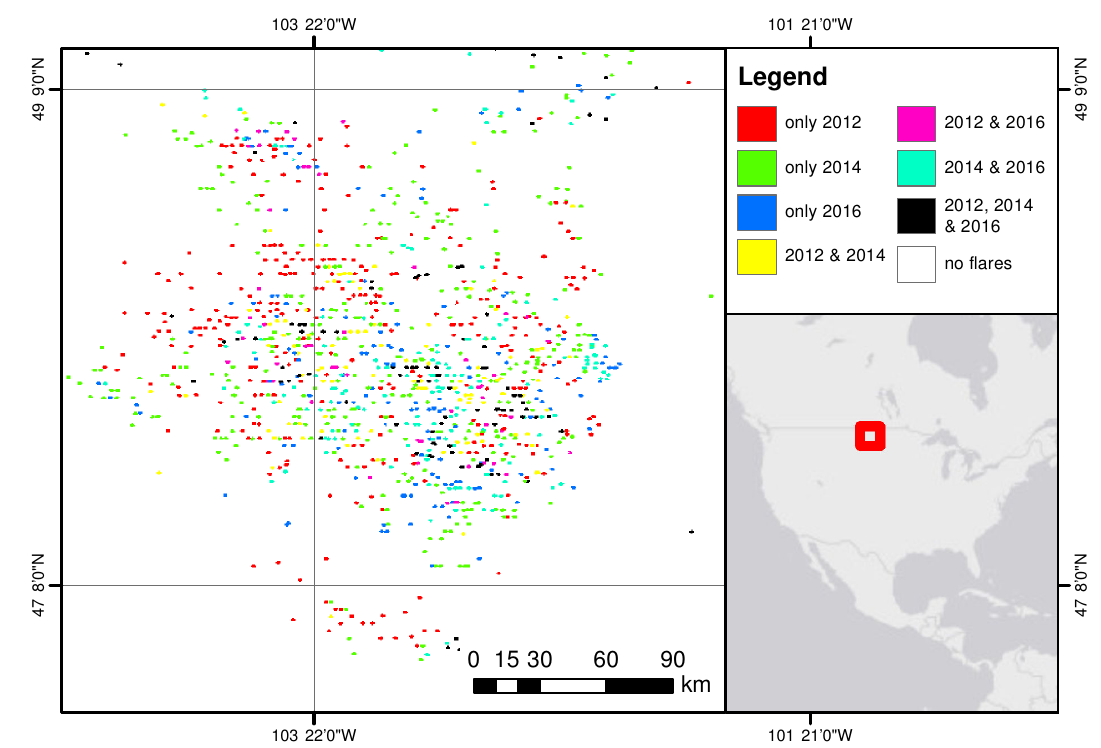
Figure 8. Active gas flares in the Bakken oil region during 2012, 2014, and 2016. Sites with an average radiance above 10 nW/cm 2 sr were considered to be lit. Map data in the bottom right panel c (cid:13) OpenStreetMap